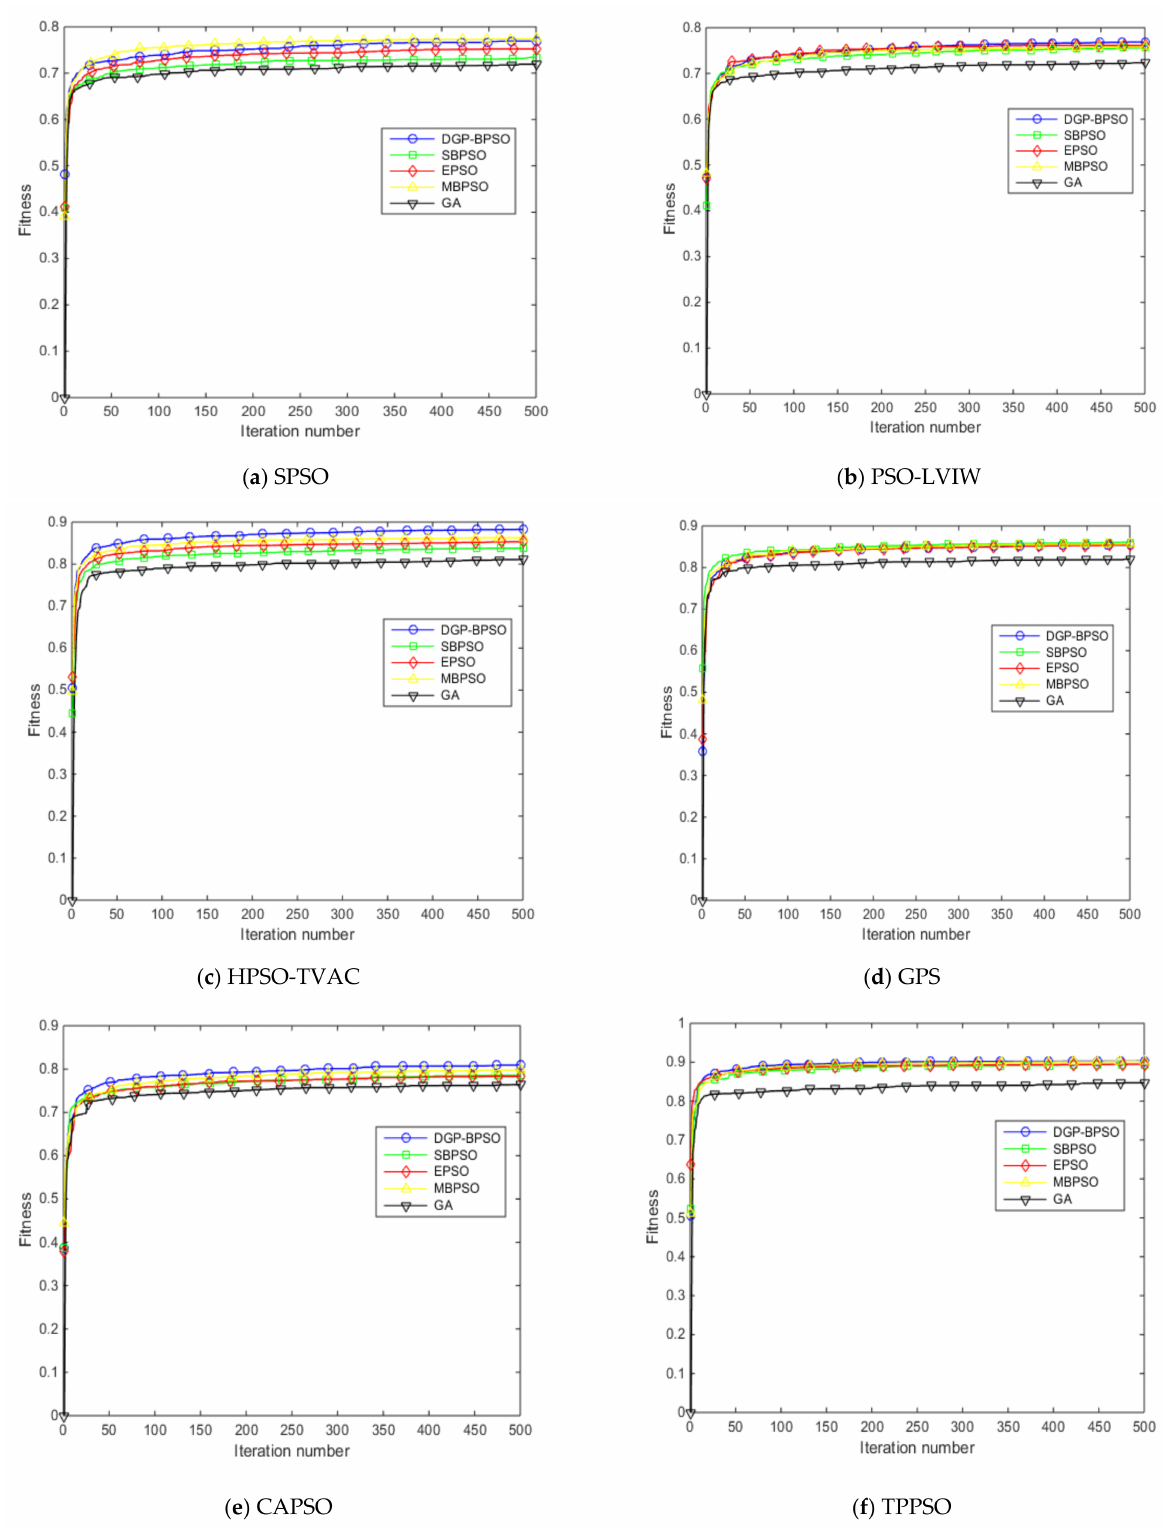
Figure 5. Convergence graphs of the hybrid PSO variants for the balanced scenario. The PSO-LVIW achieves similar average fitness results as the SPSO. The best per- formance in terms of average fitness is obtained by the PSO-LVIW with DG-BPSO and PSO-LVIW with EPSO. Although PSO-LVIW with EPSO and PSO-LVIW with DG-BPSO achieve the same average fitness, PSO-LVIW with DG-BPSO is more stable than